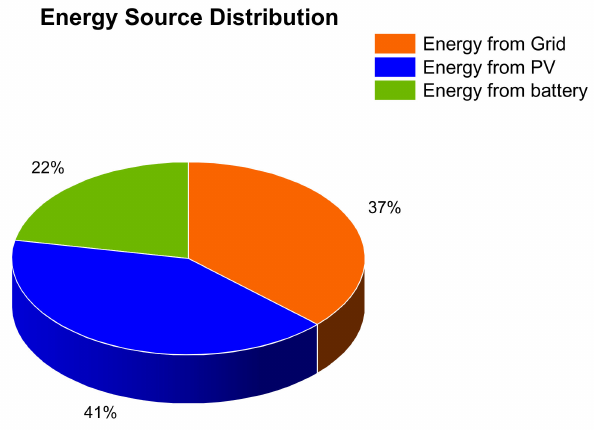
Figure 15. Energy distribution of the PV and battery system.